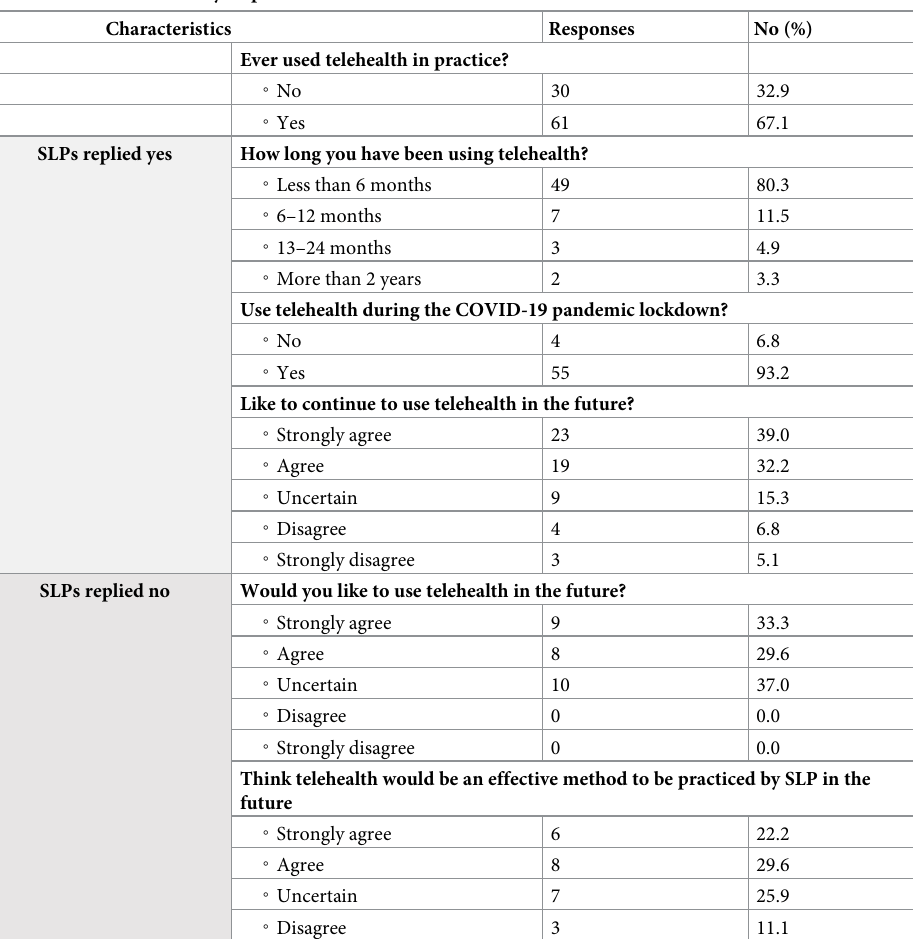
Table 2. Use of telehealth by respondent